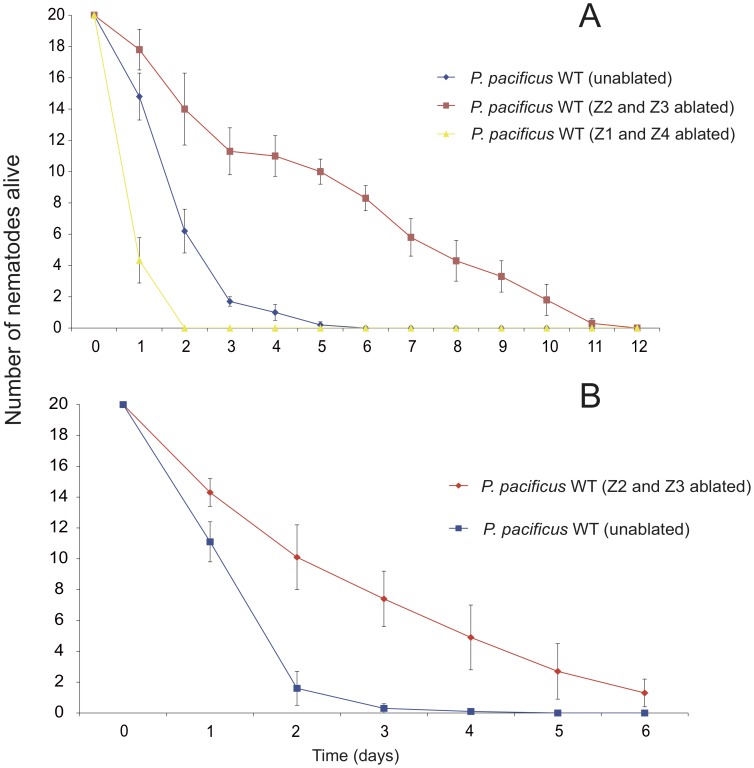
Effect of ablation of survival of P. pacificus fed bacterial pathogens.Number of alive P. pacificus WT (blue), Z2 and Z3 ablated (red) and Z1 and Z4 (yellow) exposed to S. marcescens (A) and X. nematophila (B). Batches consisting of twenty nematodes were added separately to three plates and survival was monitored daily beginning on day 0. Error bars represent ± S.E.M.